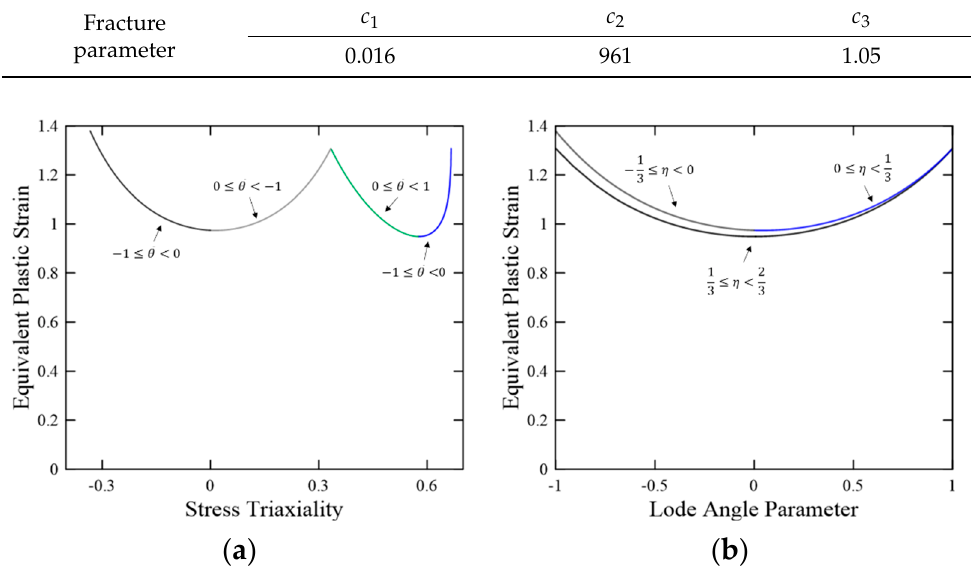
Figure 10. Fracture loci of the modified Mohr–Coulomb fracture model in accordance with ( a ) stress triaxiality and ( b ) Lode angle parameter of 304L stainless steel. Table 4. Fracture parameters of the modified Mohr–Coulomb fracture model for 304L stainless steel